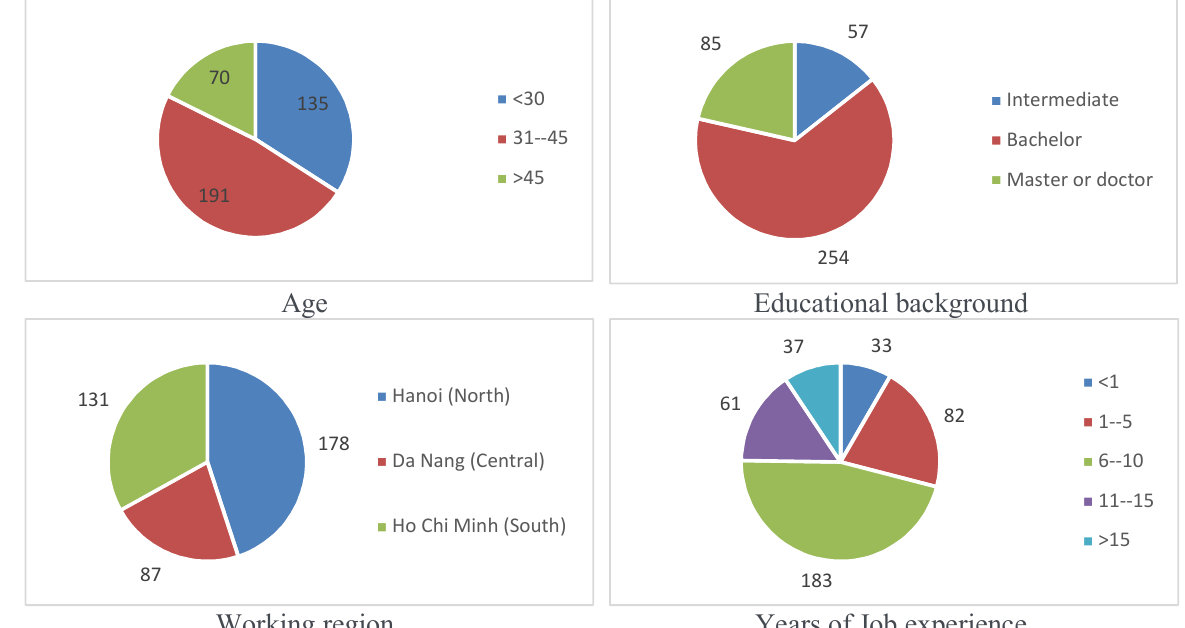
Fig. 2. Personal characteristics of the